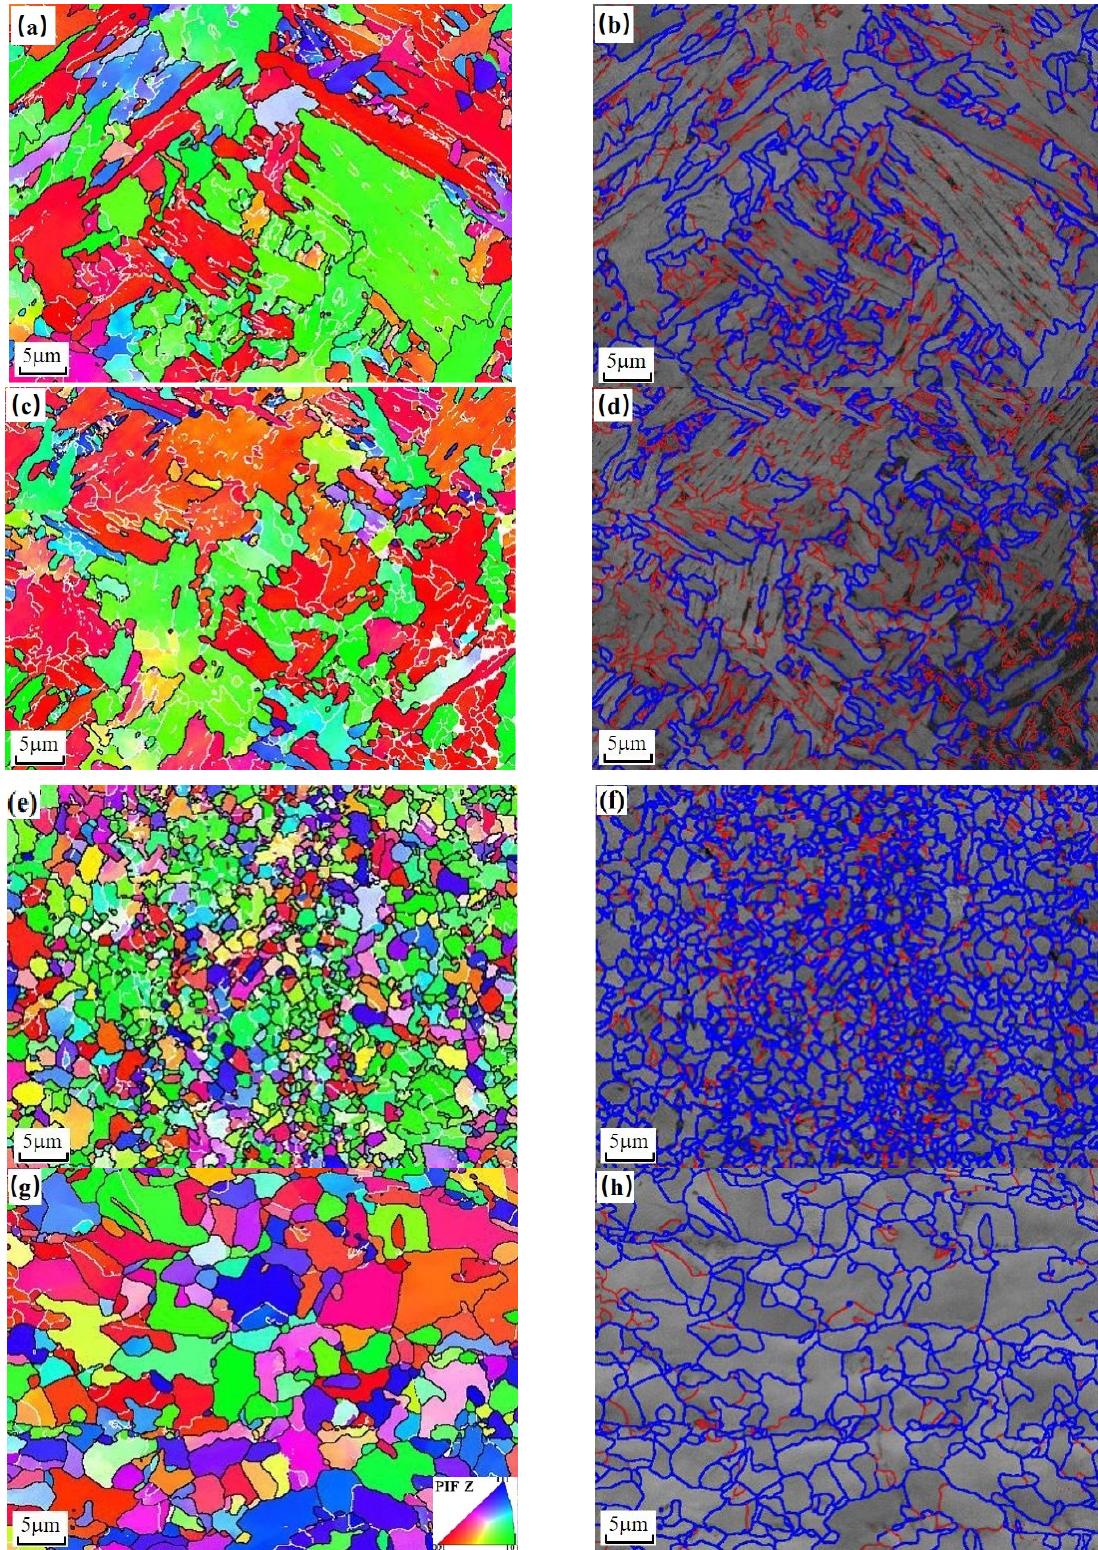
Figure 9. IPF and distribution of grain orientation of EBSD analysis results. ( a , b ) WS; ( c , d ) CGZ; ( e , f ) FGZ; ( g , h ) BM. ( e , f ) FGZ; ( g , h )